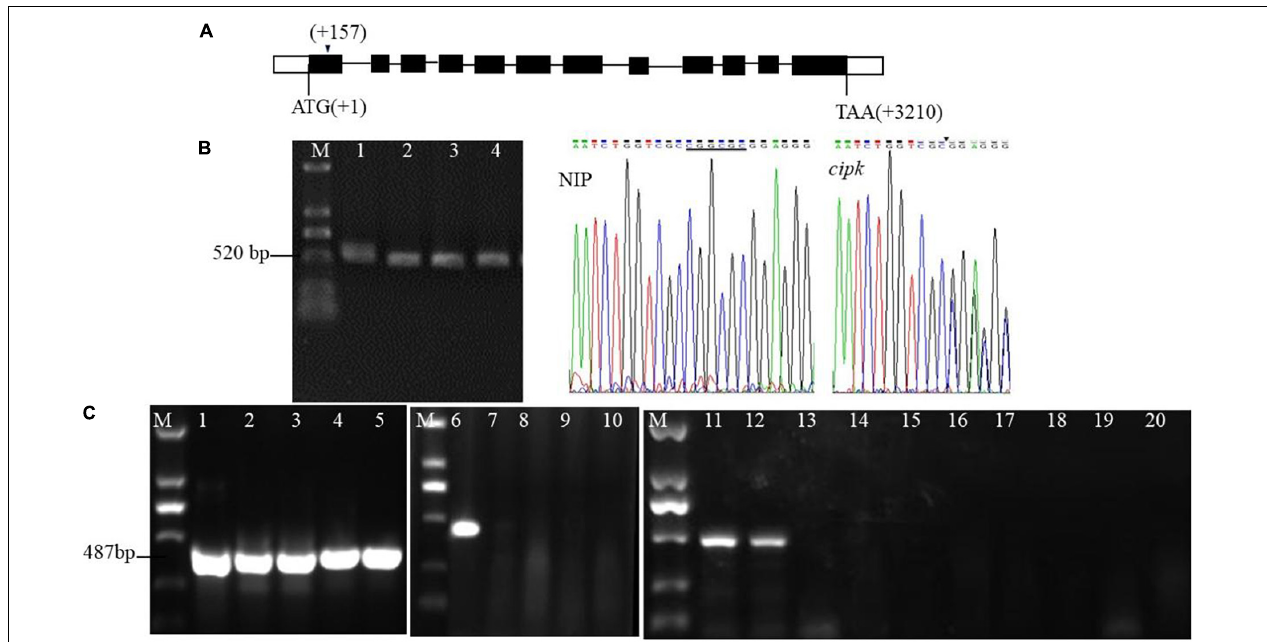
FIGURE 1 | Target design of cipk17 and identification of mutant lines. (A) OsCIPK17 gene structure and target location; (B) PCR amplification of the target fragment of cloning and sequencing method and sequencing results of the target sequence. M: DL2000 maker; 1–4: 4 individual plants of mutant cipk17 ; Nip: it is the sequencing map at the target of wild-type Nipponbare; cipk17 : sequencing map at target (AATCTGGTCGCCGGCGCGGAGGG) of mutant. The underline shows that there is six bases CGGCGC in wild-type, while are missing in the mutant line at the arrow; (C) the mutant cipk17 was identified by Hua et al. (2017). 1–5: screening the annealing temperature Tm of specific primers of the OsCIPK17 gene by gradient PCR with the method of primer design at the target. Tm is 68, 69, 70, 71, and 72 ◦ C, respectively; 6–10: identification of wild-type and mutant cipk17 with specific Tm (72 ◦ C), 6 is Nipponbare, and 7–10 is different individual plants of mutant cipk17 ; 11–20 are the identification of tillers in the same single plant of mutant. 11–12 are Nipponbare, 13–20 are different tillers of the same plant in mutant line, respectively; M: DL2000